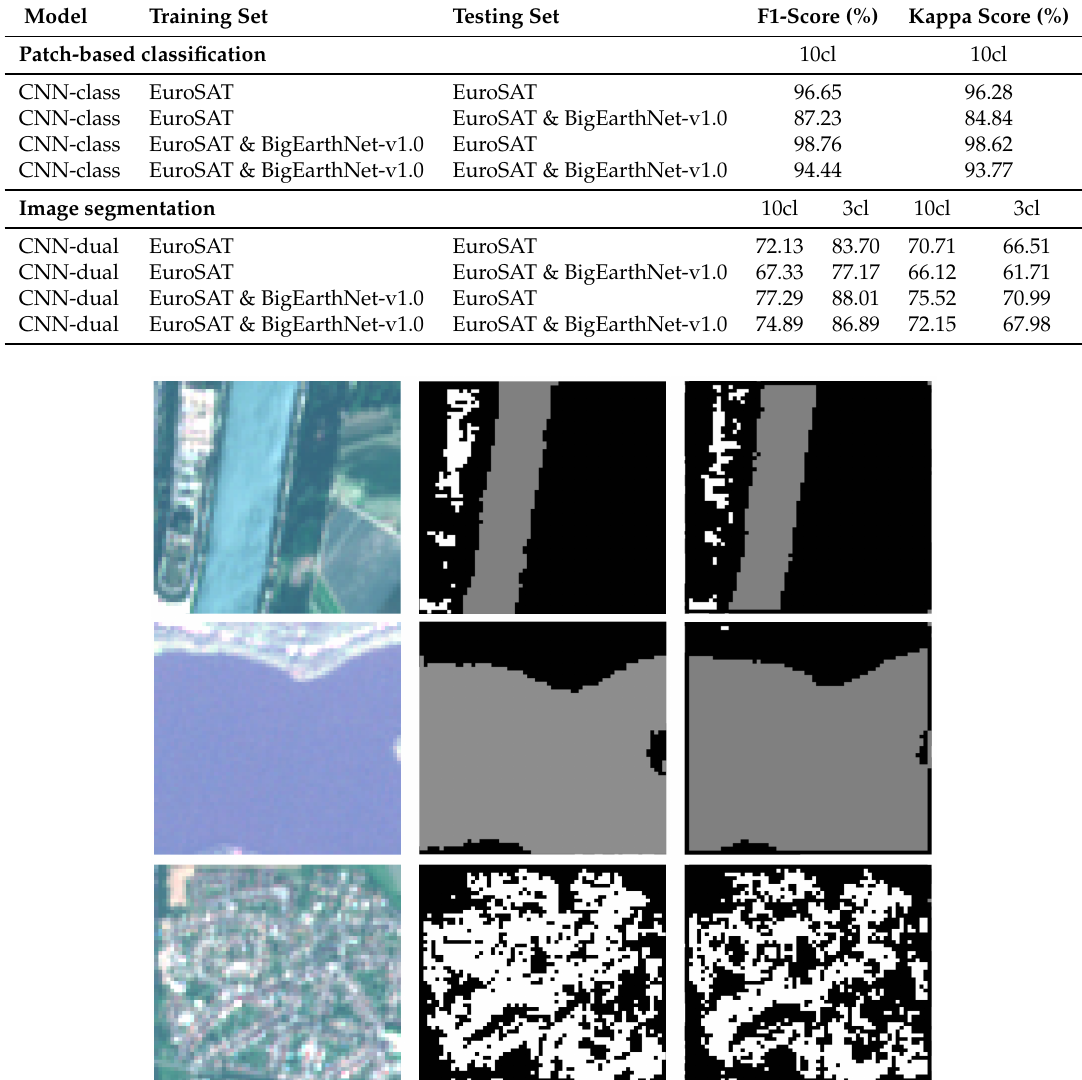
Figure 5. Image patches (64 × 64) of the EuroSAT data set kept out for testing. The first column displays the RGB composition, the middle column shows the output of the CNN-segm, and the last column displays the segmentation result of the CNN-dual model. The CNN-class classifies correctly the three image patches to river , sea lake , and residential ,